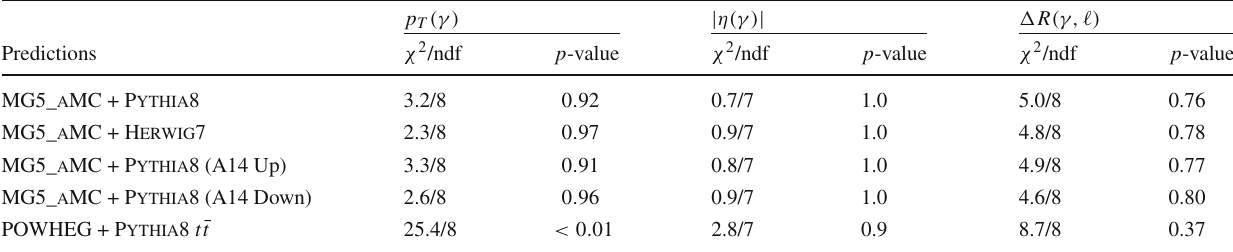
Table 7 χ 2 /ndf values and p -values between the measured normalized differential cross-sections and predictions from several generators in the single-lepton channel